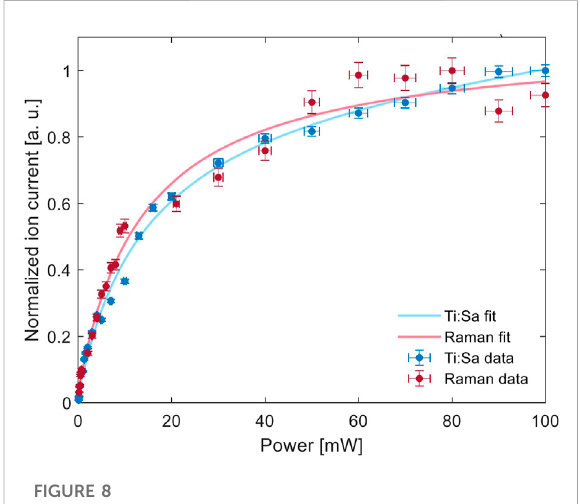
FIGURE 9 Measured spectra for the excitation of the transition while performing a frequency sweep with the Raman and Ti:Sa lasers wavelength and the resulting linewidths for both